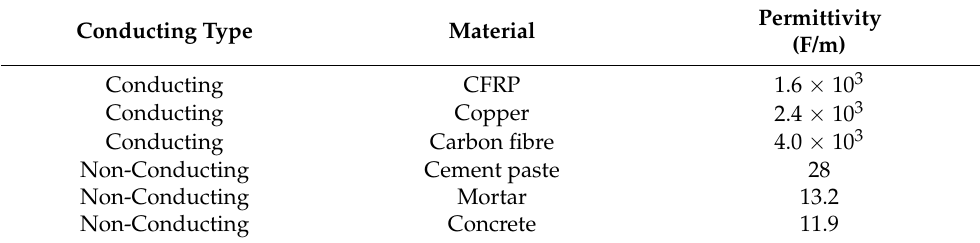
Table 10. Permittivity and resistivity values for different materials.